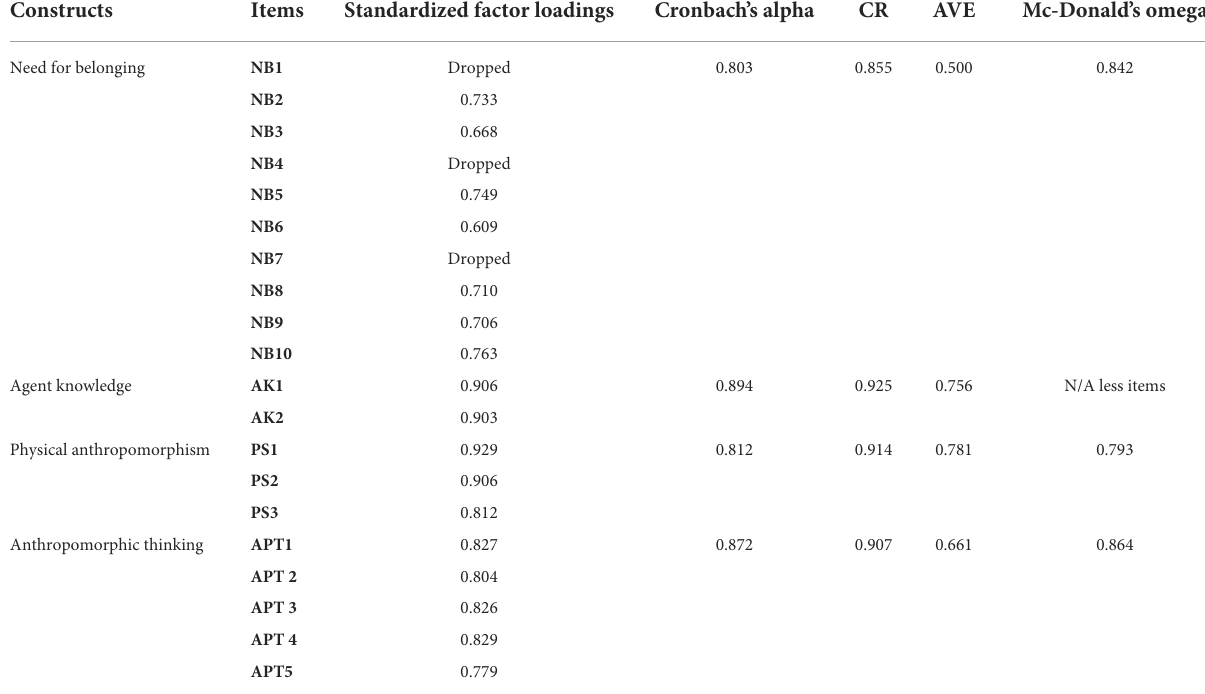
TABLE 2 Latent constructs with standardized factor